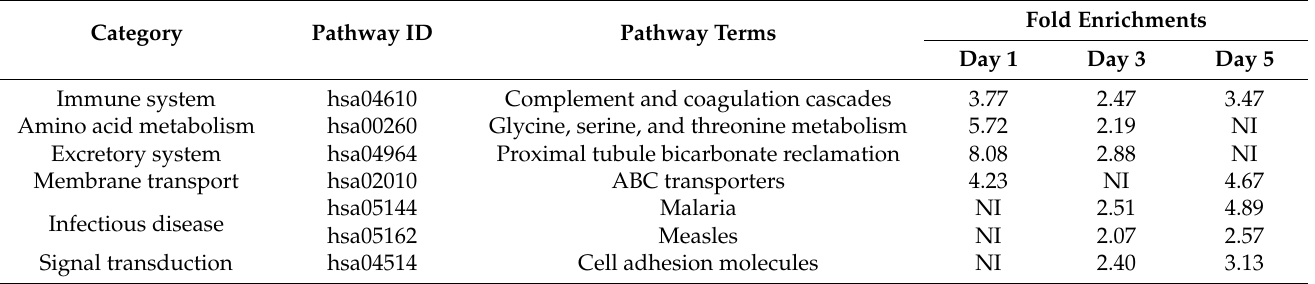
Table 4. KEGG pathways commonly identified in IHNV-infected